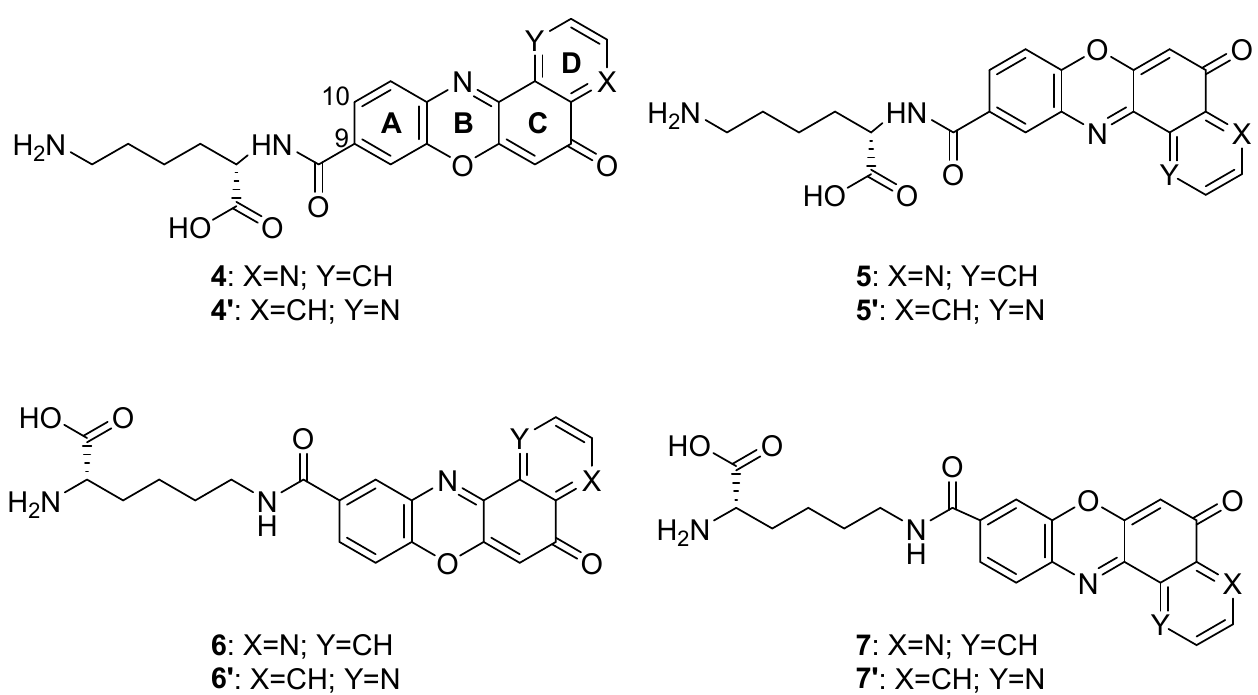
Figure 10. Structure of the pyridophenoxazinone derivatives conjugated to L -lysine. Products 4–7 and 4 ′ -7 ′ were tested on cancer cell lines of leukemia (CCRF-CEM, CCRF-SB and MT-4), colon (HT-29), breast cancer (MCF-7), cervical cancer (HeLa), papil-